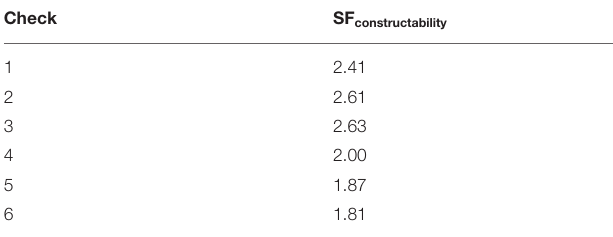
TABLE 3 | Factors of safety for the global and internal ULS requirements for the example block wall. Block LC Global 1 2 3 4